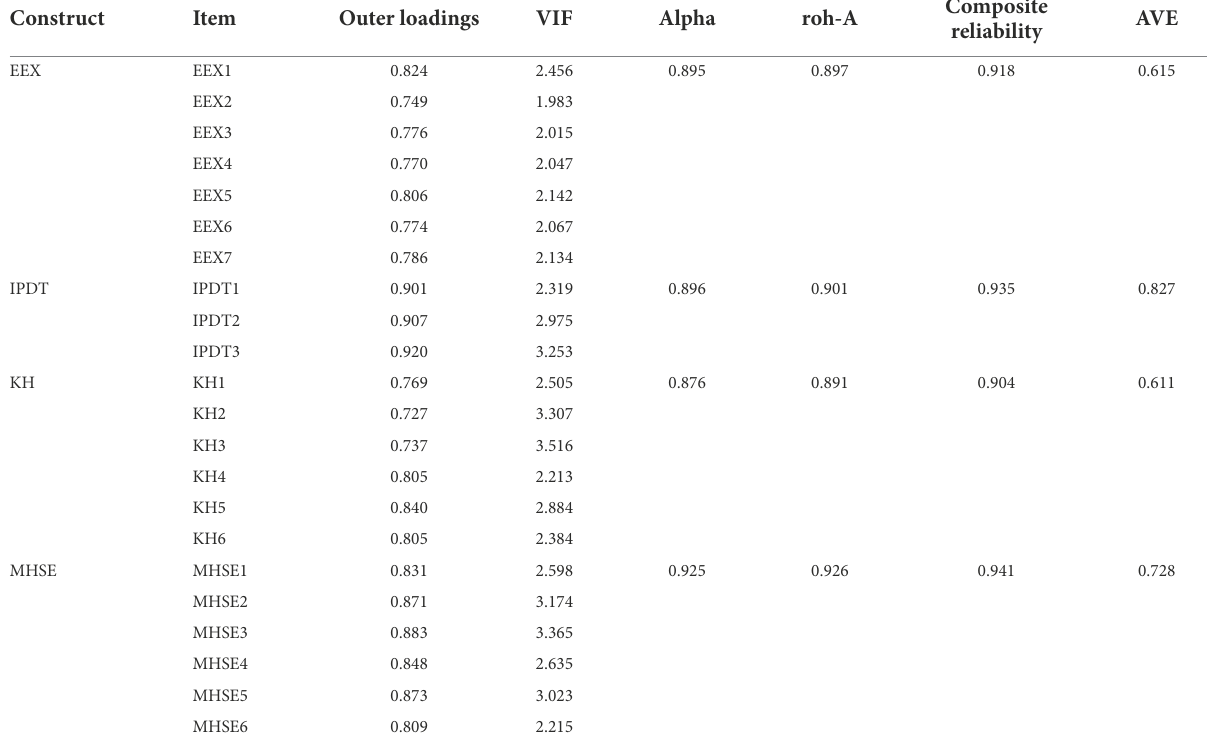
TABLE 6 Reliability and convergent validity of the study constructs (moderation).